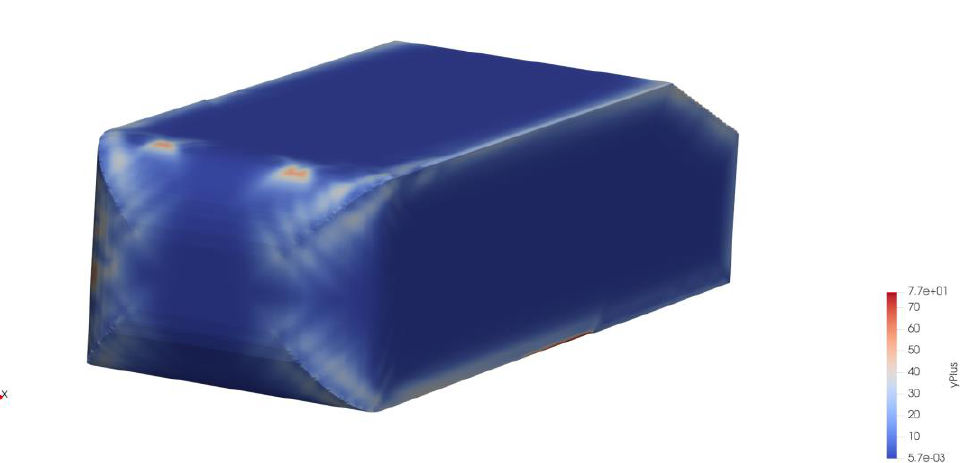
Figure 10. Y+ value around Ahmed Body.